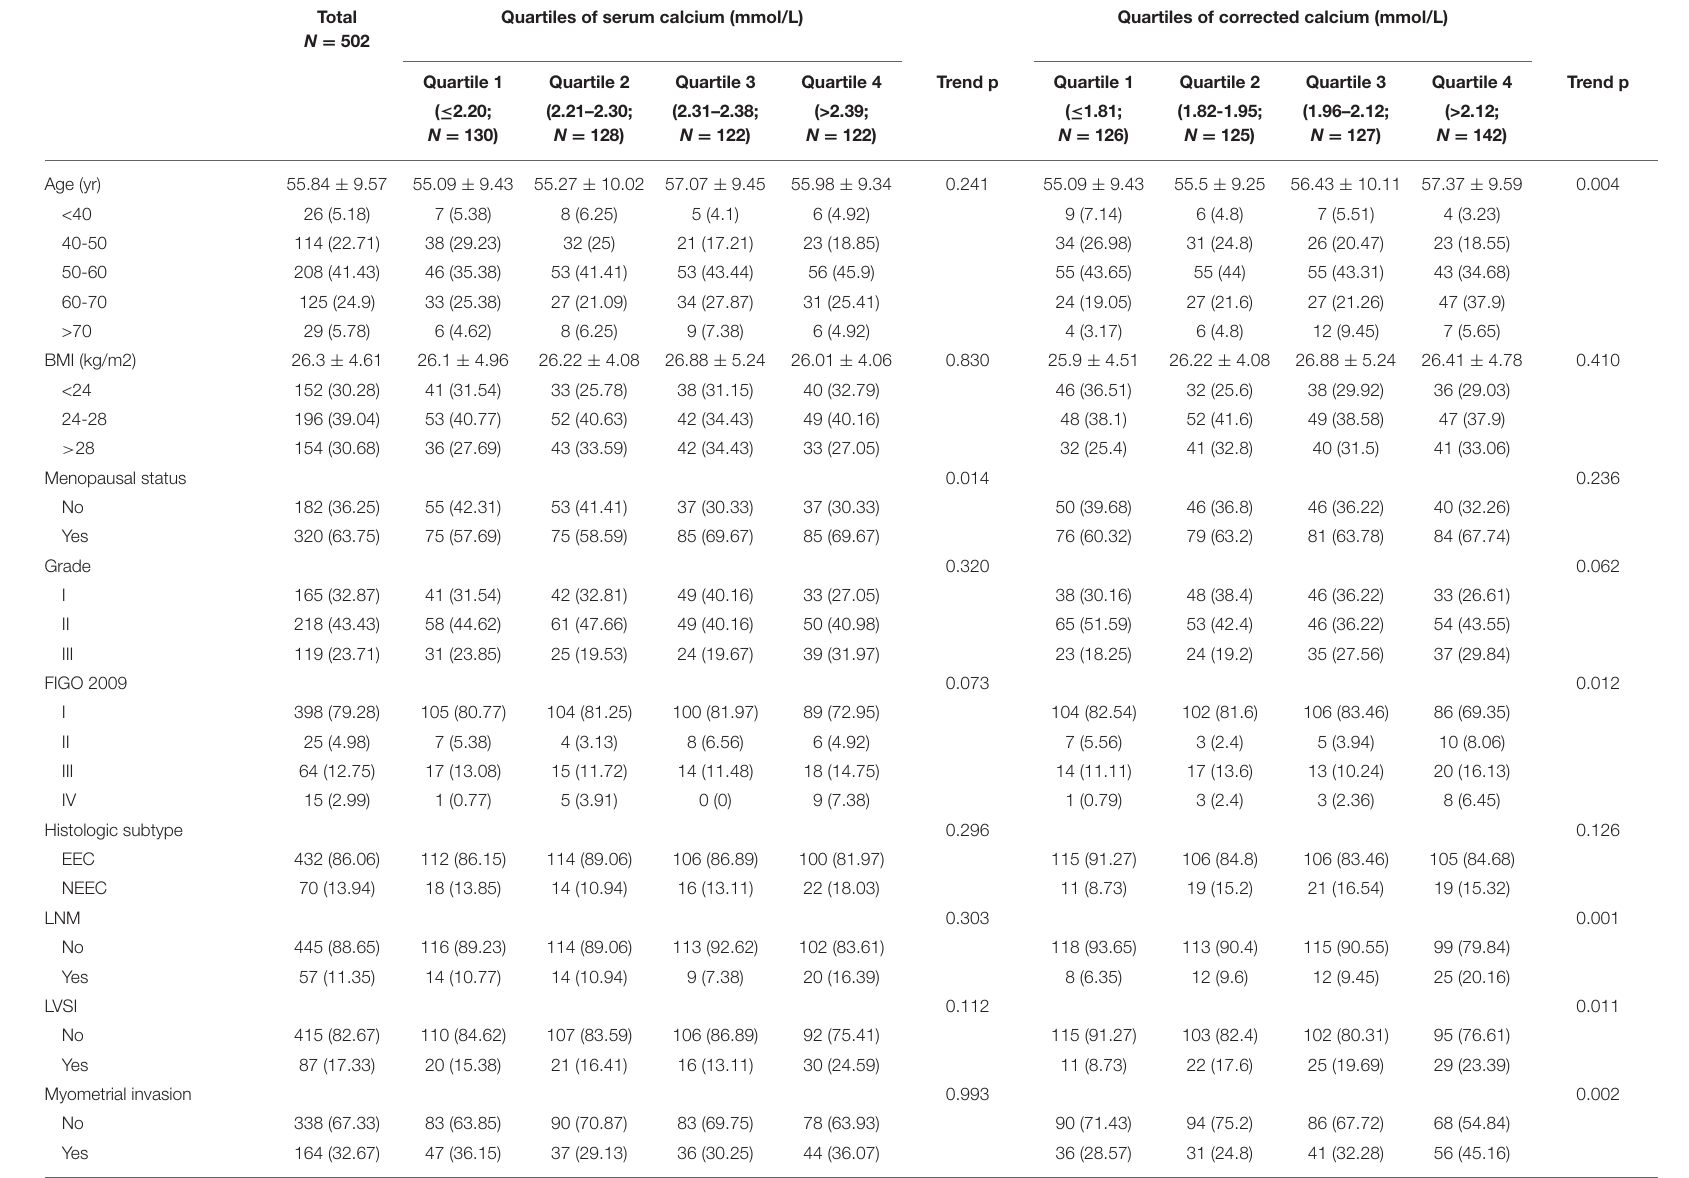
TABLE 1 | Demographic characteristics for EC patients according to quartiles of serum calcium and corrected serum